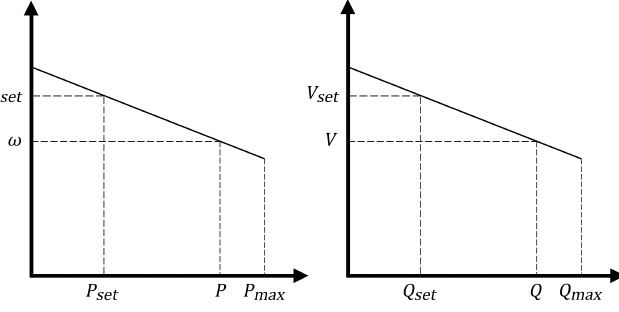
Figure 1. Droop Control